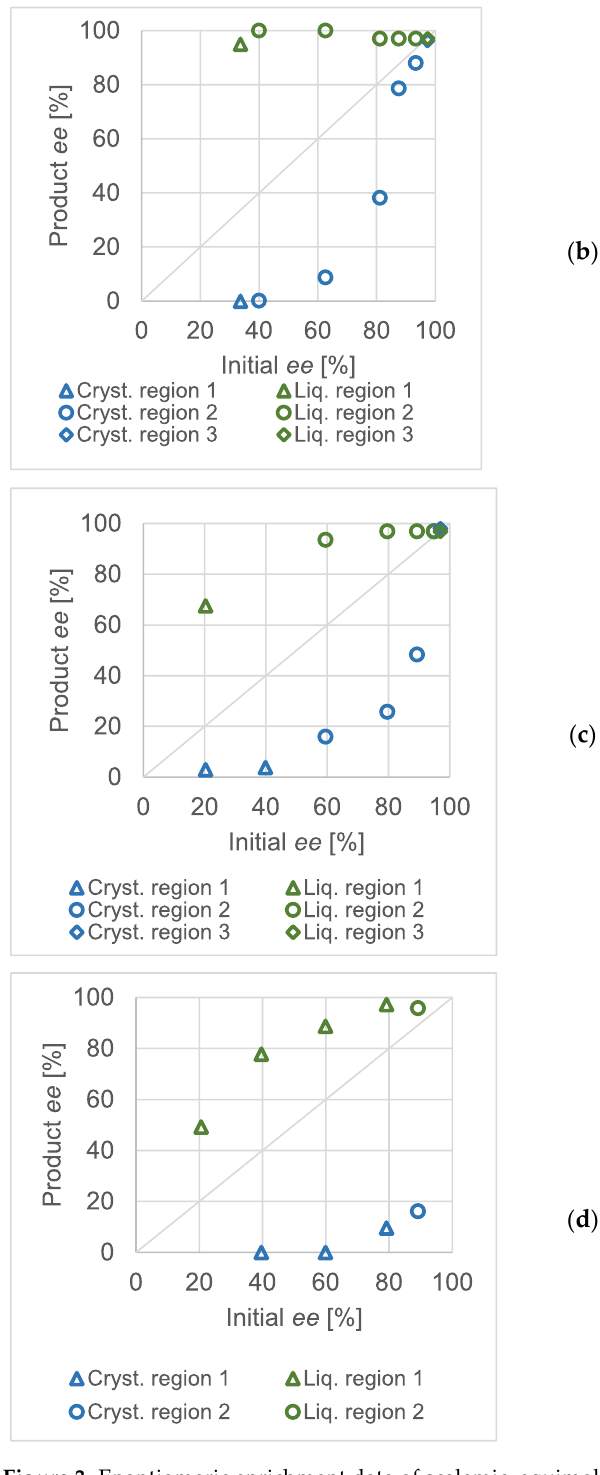
Figure 3. Enantiomeric enrichment data of scalemic, equimolar benzylammonium mandelate salts at an ambient pressure at 1°C. ( a ) Total salt concentration: 124.9 mg/mL; ( b ) total salt concentration: 85.1 mg/mL; ( c ) total salt concentration: 58.5 mg/mL; ( d ) total salt concentration: 29.38 mg/mL. The triangular markers show the experiments where a racemic solid was expected (zone 1). The circles correspond with compositions where one may expect a eutonic mother liquor and the diamonds show the results with an enantiomerically pure solid phase. Naturally, the exact enantiomeric excess values were loaded with an error resulting